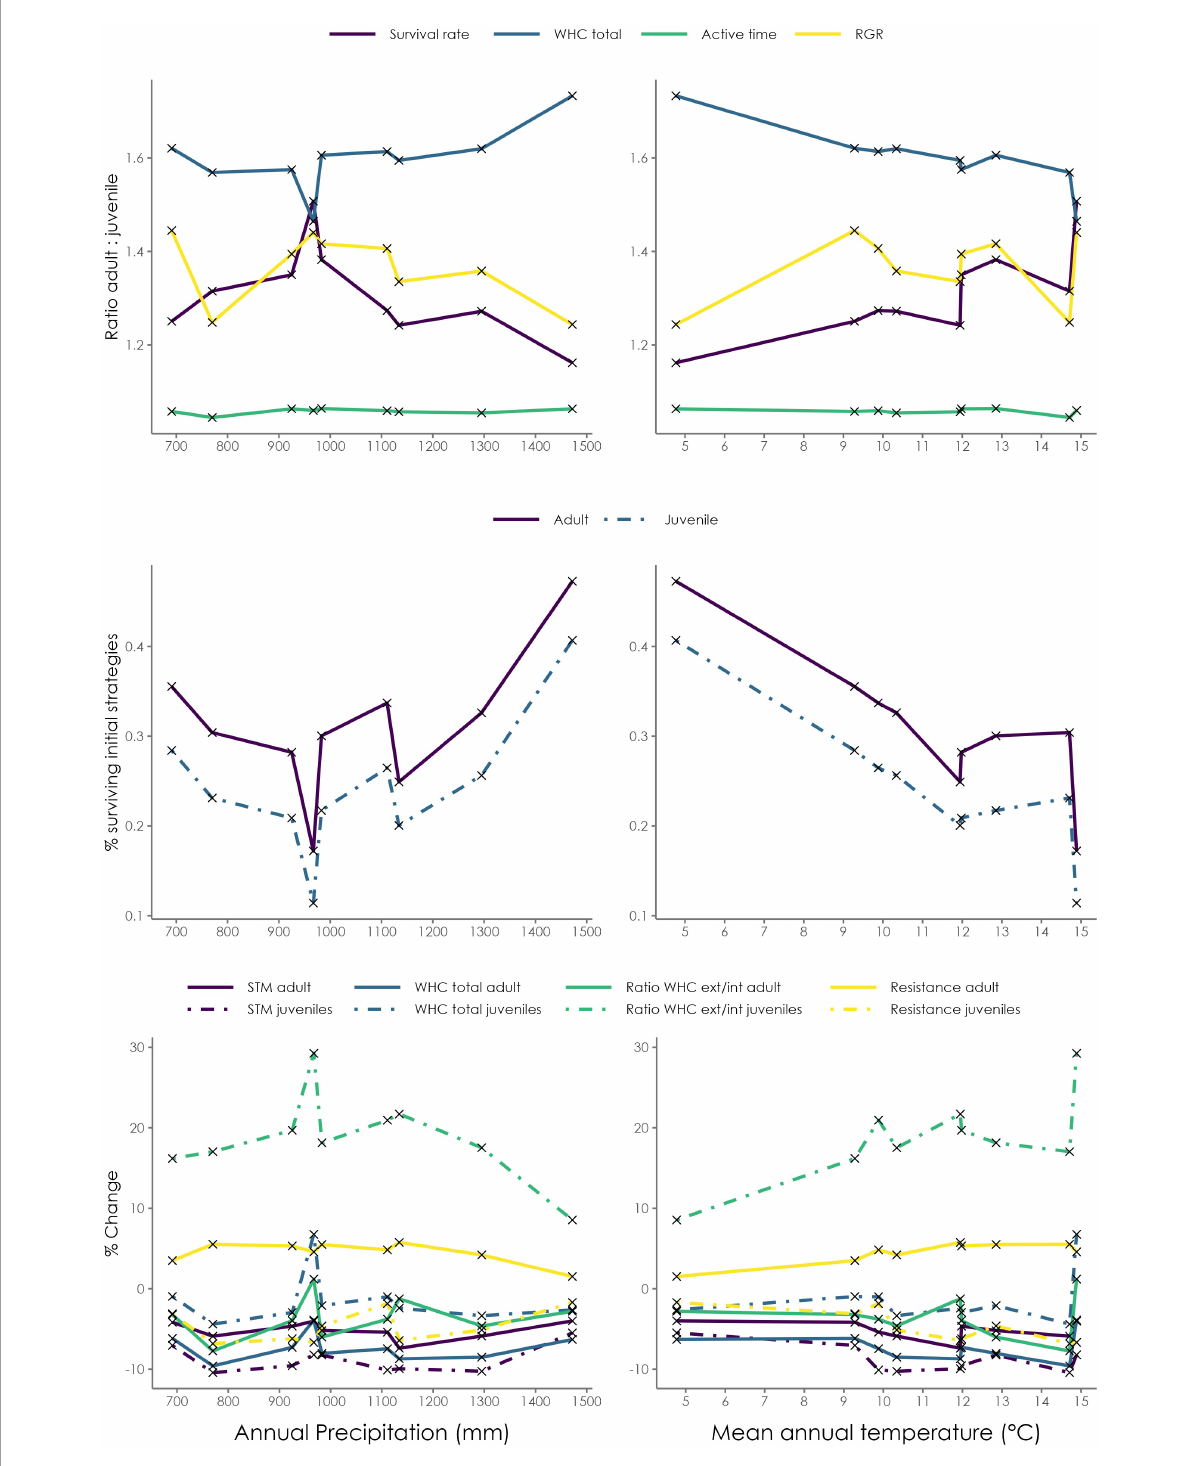
FIGURE7 (Top) Simulated ratios of adult to juvenile survival rate (purple), Water holding capacity—WHC LiBry (blue), Active fraction—Act.Frac. (yellow) and Relative Growth Rate—RGR (yellow) for the 9 regions in Italy examined here. The climate variable increases from left to right, total rainfall (Left) , and average air temperature (Right) . (Middle) survival rates of adult (purple) and juvenile (blue) thalli. (Bottom) Shift in the community mean values of four hydration traits from the initial strategies to those surviving at the end of the simulation; STM (purple), WHC LiBry (blue), the ratio of external to internal WHC (green), and resistance against evaporation (yellow) are shown separately for adult thalli (solid) and juvenile ones